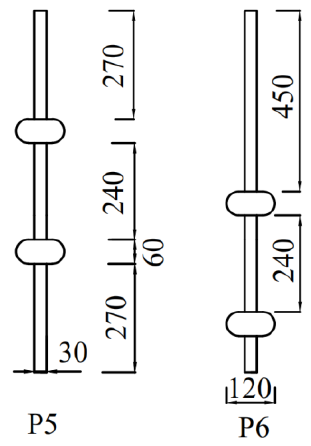
Figure 10. Geometric scheme of numerical simulation.